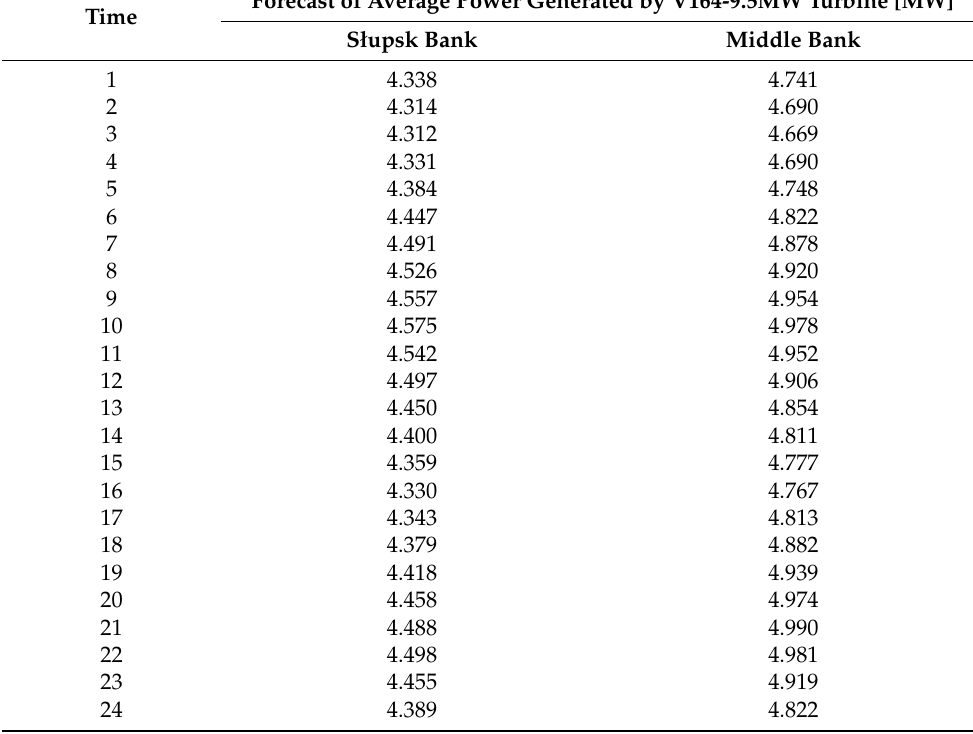
Table 7. Forecast of average hourly power generated in the V164-9.5MW turbine.